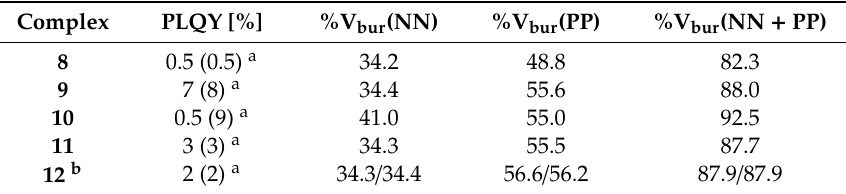
Figure 8. Scatter plots of PLQY, %V bur (NN), %V bur (PP) and %V bur (NN + PP) for compounds 8 – 12 [31]. ( a ) Scatter plot of PLQY vs. %V bur (NN). ( b ) Scatter plot of PLQY vs. %V bur (PP). ( c ) Scatter plot of PLQY vs. %V bur (NN + PP). ( d ) Scatter plot of %V bur (NN) vs. %V bur (NN + PP). ( e ) Scatter plot of %V bur (PP) vs. %V bur (NN + PP). ( f ) Scatter plot of %V bur (NN) vs. %V bur (PP). 2.5. Case Study 3—Differentiating Steric from Electronic Factors In 2016, two of us reported a series of heteroleptic [Cu(NN)(PP)] + complexes with 6- or 6,6’- substituted bpy ligands in combination with POP or xantphos ( 13 – 18 , Figure 9) [18]. Following investigations of the structural and photophysical properties, the complexes were tested in LECs and were also investigated using DFT calculations. While high PLQY values were obtained for complexes